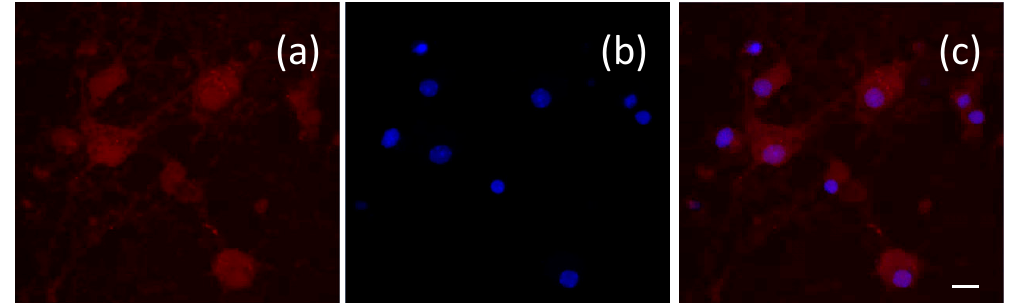
Figure 6. Intracellular localization of dextran 70,000-coated SPIO-NPs labelled with rhodamine 123 in primary hippocampal neurons after 24 h of incubation. The rhodamine 123 fluorescence shows similar distribution as in the C6 cells: ( a ) rhodamine 123 labelling, ( b ) blue staining of nuclei with Hoechst 33342, ( c ) merge of images ( a , b ). Scale bar 20 µm.